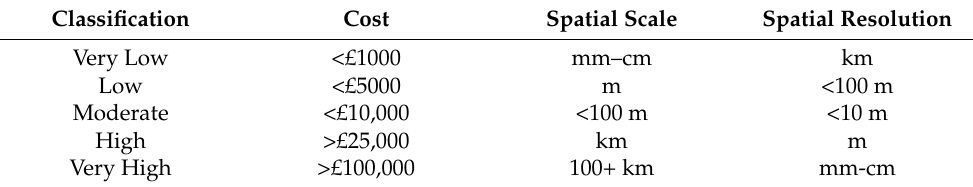
Table 3. Guide to rankings for each classification outlined in Table 2.